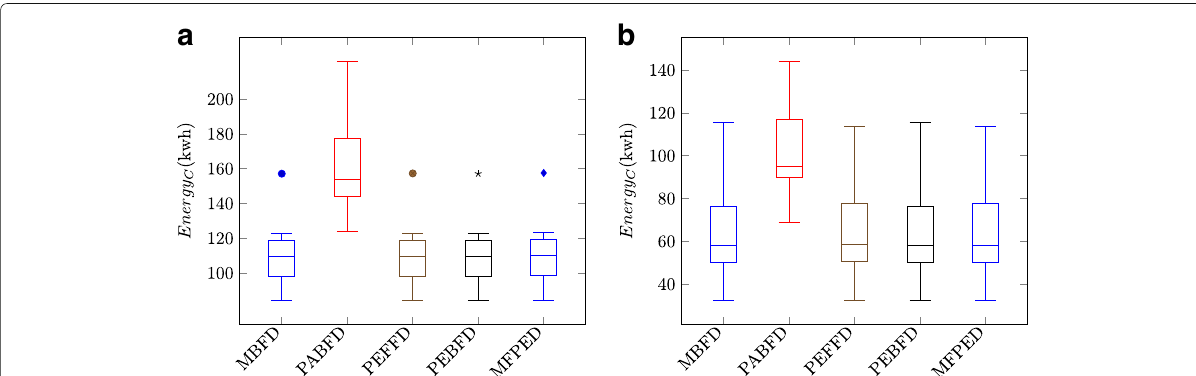
Fig. 4 Comparison by energy efficiency of algorithms in the Homogeneous-scenario. Total energy consumption in data-center with one type of server: HP ProLiant ML110 G5. MBFD and PABFD are the baseline algorithms and the rest are the proposed ones. a Results using PlanetLab traces. b Results using Bitbrains